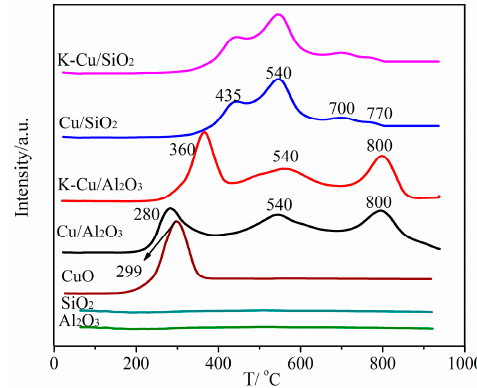
Figure 3. H 2 -temperature-programmed reduction (H 2 -TPR) profiles of Al 2 O 3 , SiO 2 , CuO, Cu/Al 2 O 3 , K-Cu/Al 2 O 3 and Cu/SiO 2 , K-Cu/SiO 2 catalysts.